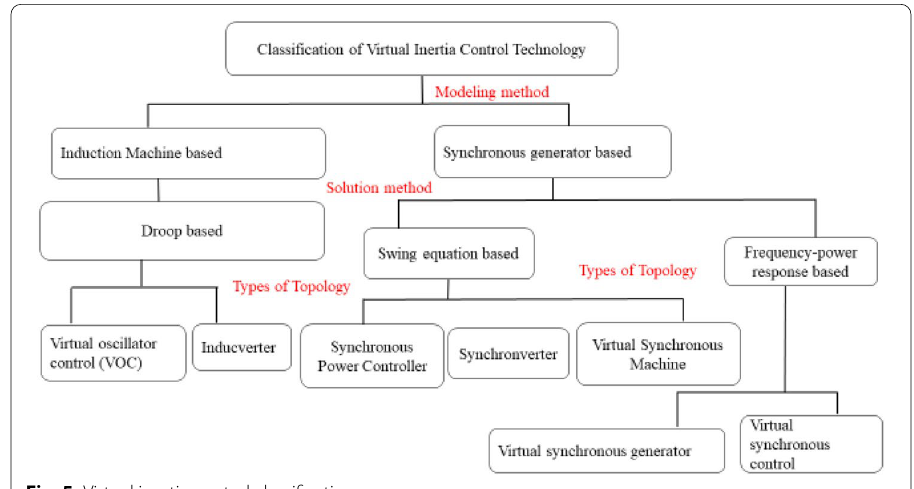
Fig. 5 Virtual inertia control